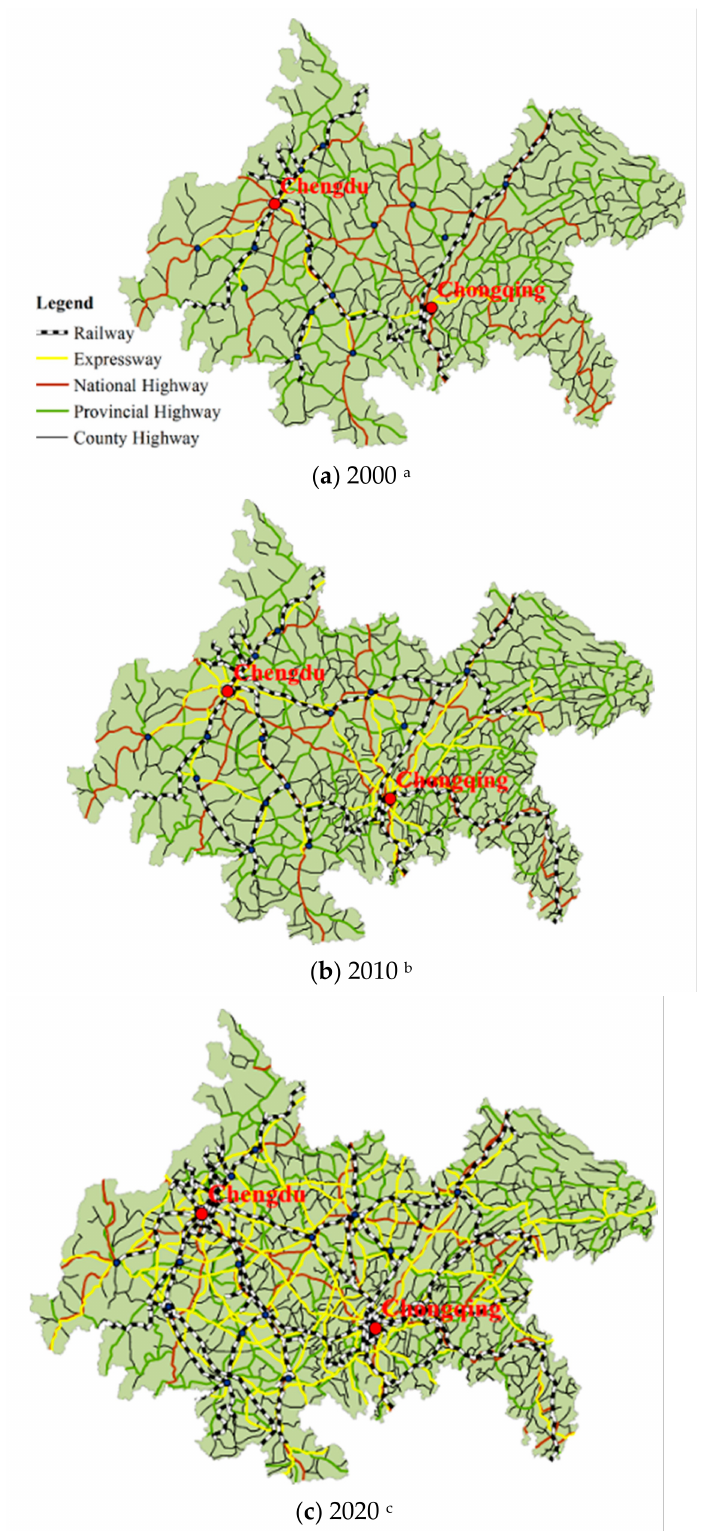
Figure 2. Transportation Networks of the CCUA. Source: a Atlas of Traffic Mileage China (2000). Beijing, CHN: People’s Communications Publishing House. b Transport Atlas of China (2010). Shaanxi, CHN: Xi‘an Map Publishing House. c Transport Atlas of China (2000). Beijing, CHN: Sinomap